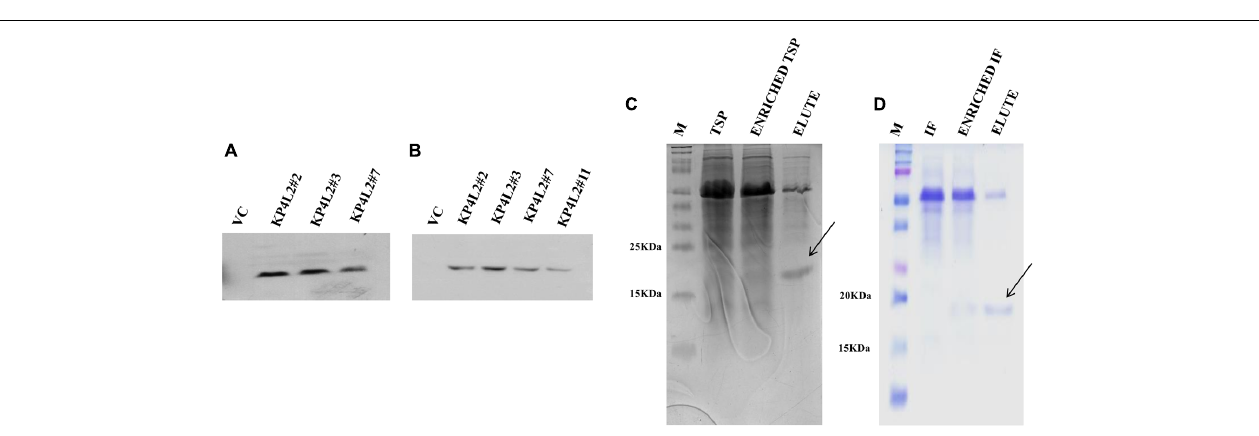
FIGURE 6 | Western blot analysis of KP4 protein expression in transgenic tobacco plants using (A) anti-His polyclonal and (B) anti-His monoclonal primary antibody. Coomassie-stained 15% SDS-PAGE showing the partial purification of KP4 from (C) TSP and (D) IF fractions from pKMUASCsV8CP-KP4His transformed line